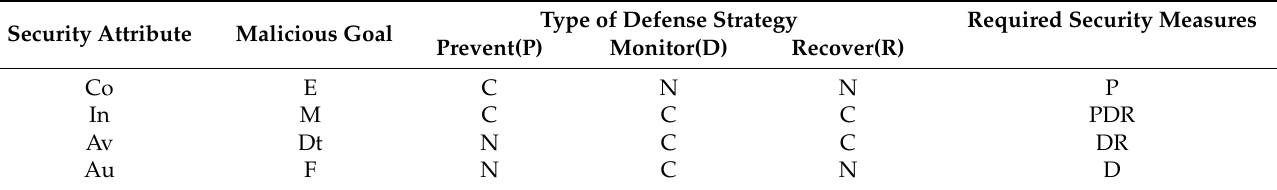
Table 1. The calculation matrix of security measures required for assets. Type of Defense Strategy Required Security Measures Security Attribute Malicious Goal Prevent(P)